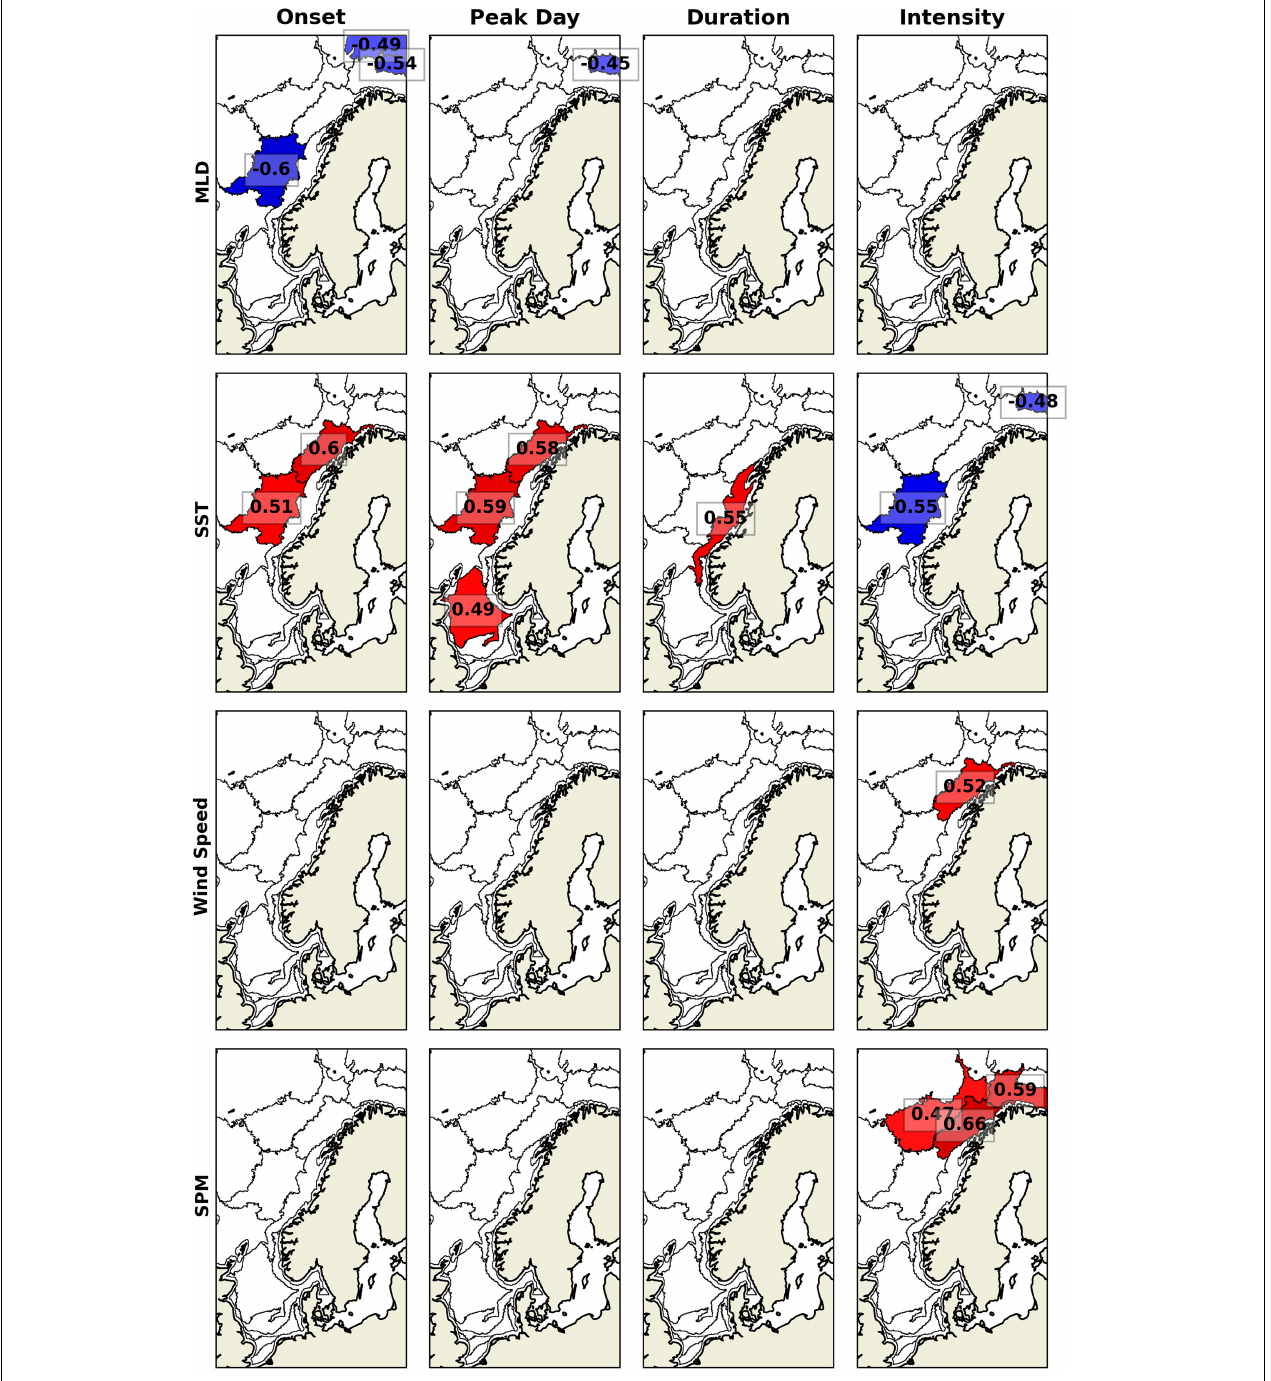
FIGURE 7 | Detrended interannual correlation between the summer bloom phenology and MLD, SST, wind speed, and SPM. Red colors are positive correlations, blue colors are negative correlations and white colors are used for insignificant correlations ( α > 0.05).